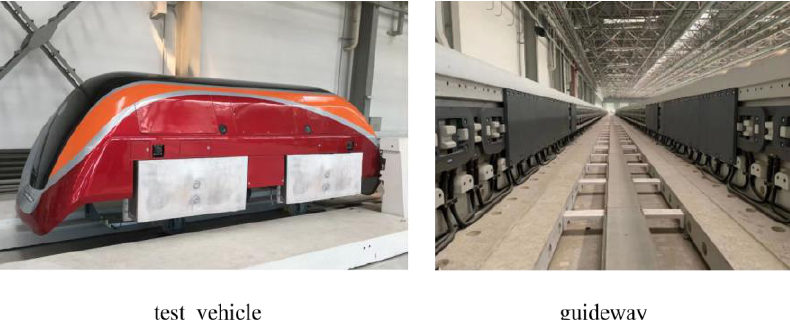
Figure 1. The 200 m straight EDS maglev test line with high-temperature superconducting (HTS) at the CRRC.